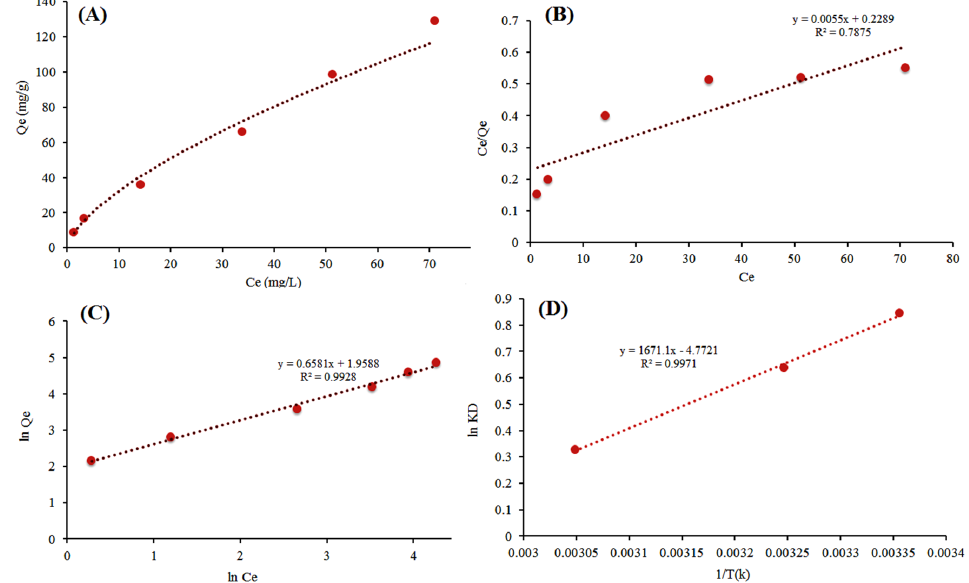
Figure 7. ( A ) Experimental adsorption isotherm for cefixime adsorption onto PG-AC5, ( B ) Langmuir isotherm, ( C ) Freundlich isotherm and ( D ) thermodynamic model.